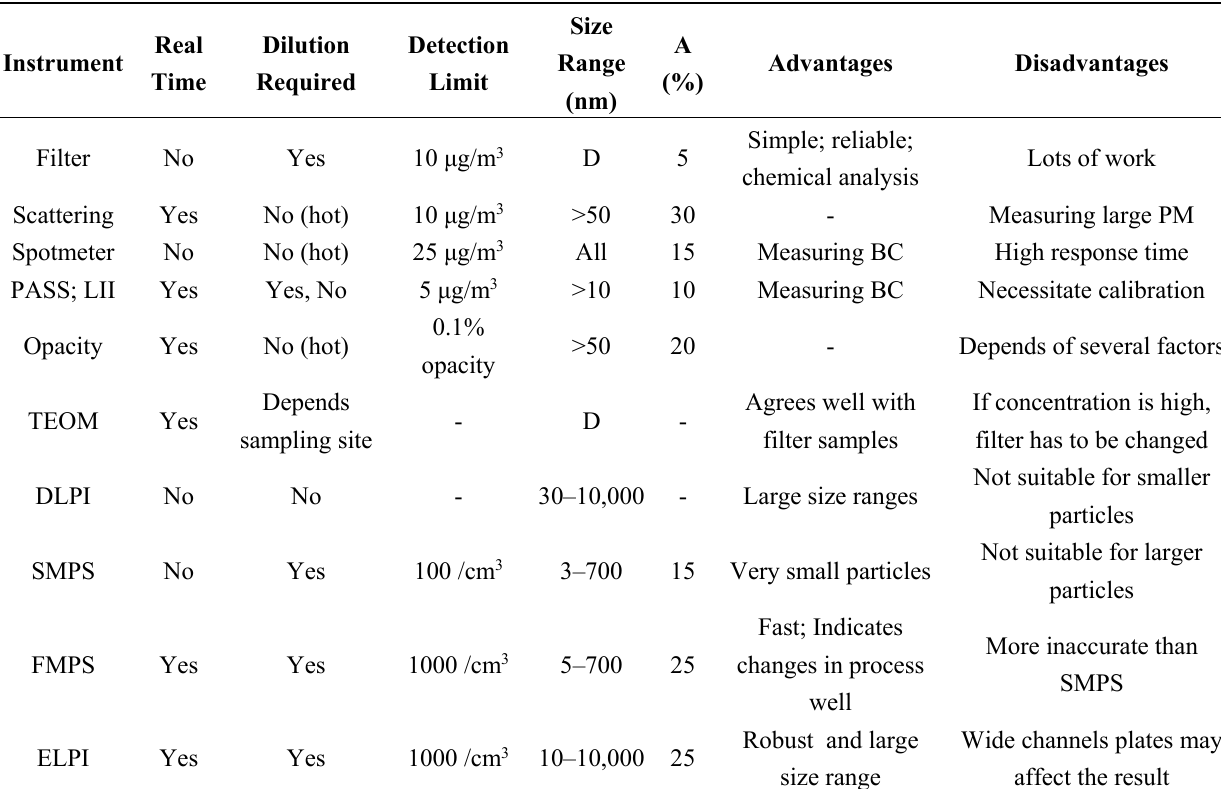
Table 1. Comparison and specifications of different instruments for particle measurement. (Adapted from